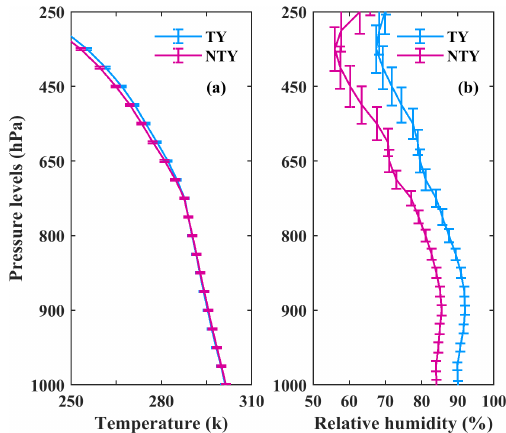
Figure 17. Radar reflectivity contoured frequency-by-altitude dia- grams (CFADs) from six ground-based radars for (a) typhoon (TY) and (b) non-typhoon (NTY) rainfall.